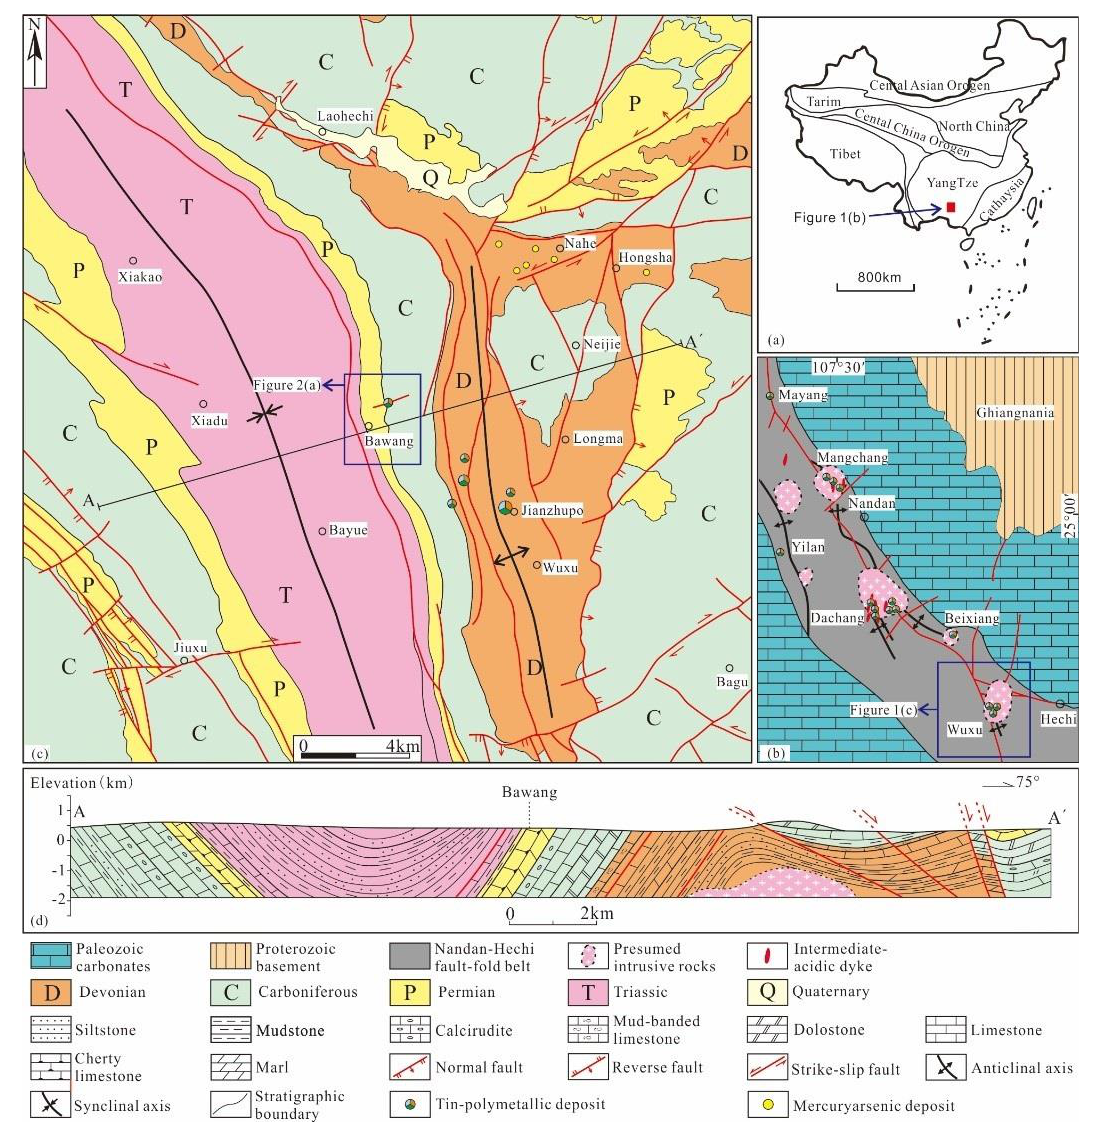
Figure 1. Geotectonic location map of the Bawang deposit ( a ); sketch map showing structural geology and mineral distribution of the Nandan-Hechi metallogenic belt ( b ); geological and deposit distribution map of the Wuxu ore field ( c ); structural sections of Wuxu ore field ( d ).